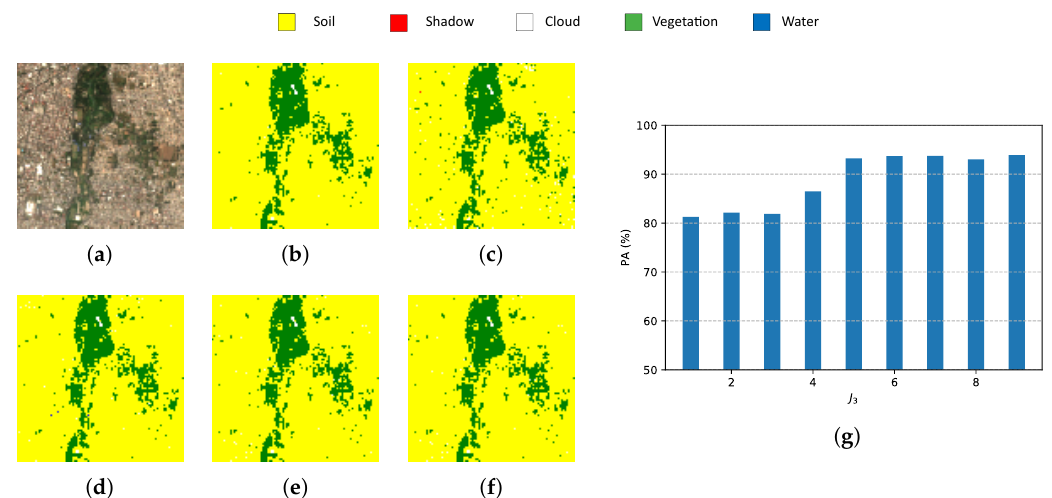
Figure 11. Qualitative results testing a scene of interest with abundant presence of soil. ( a ) Original true color scenario of 128 × 128 pixels, in Central Europe: ( b ) five classes semi-manually labeled ground truth of the MSIs, ( c ) classification with an unsupervised normalized difference index (NDI) fusion algorithm, and ( d ) output prediction after 100 epochs in the FCN used for this work without data compression. ( e ) PCA-FCN framework output; ( f ) prediction of the whole framework HOOI-FCN proposed in this work; and ( g ) PA behavior of the HOOI-FCN versus number of tensor bands.